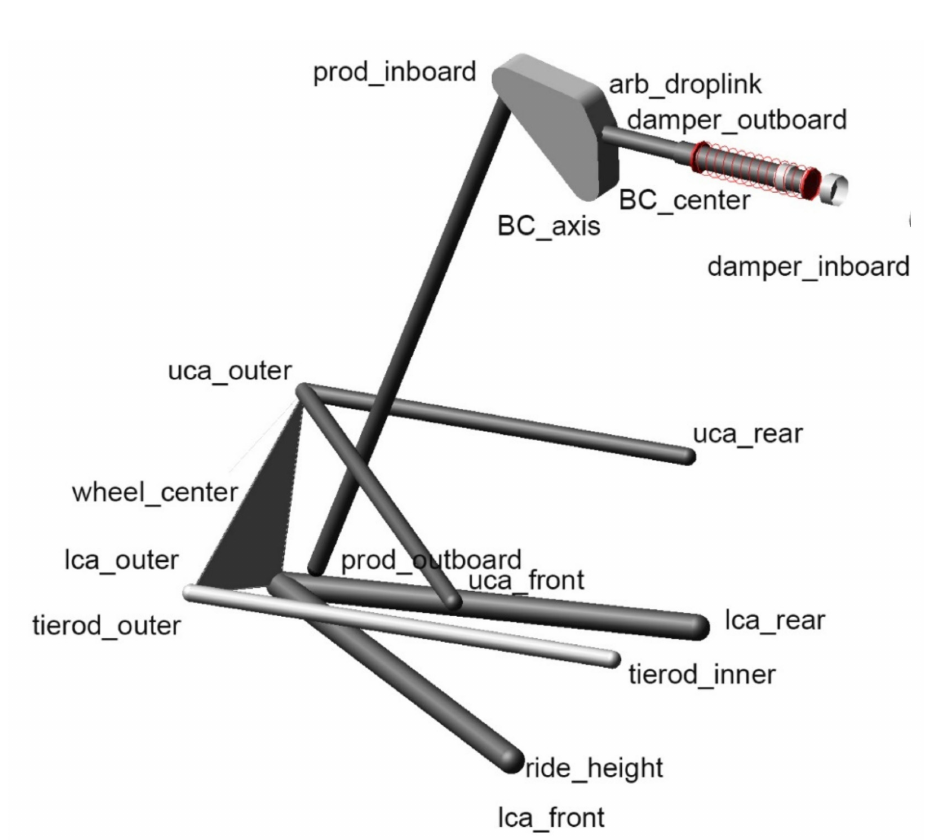
Figure A1. Details of the double wishbone front right suspension